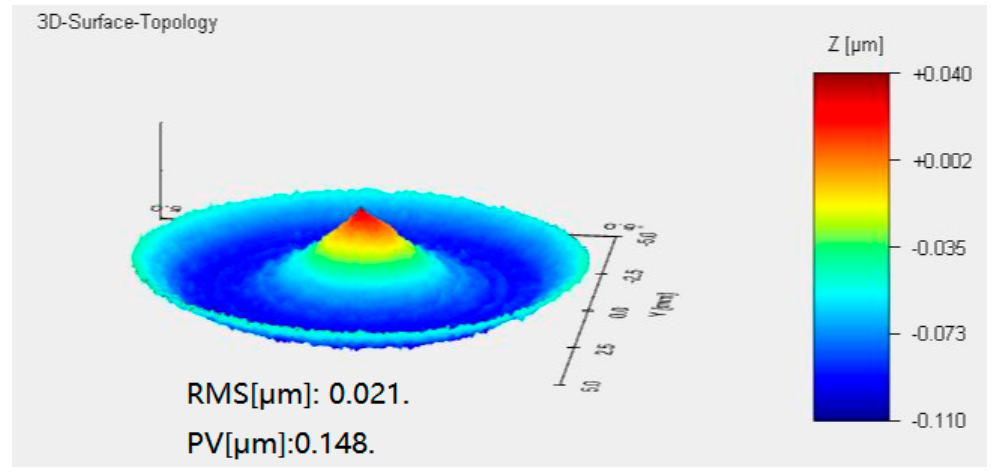
Figure 18. Testing result of rotating paraboloid.